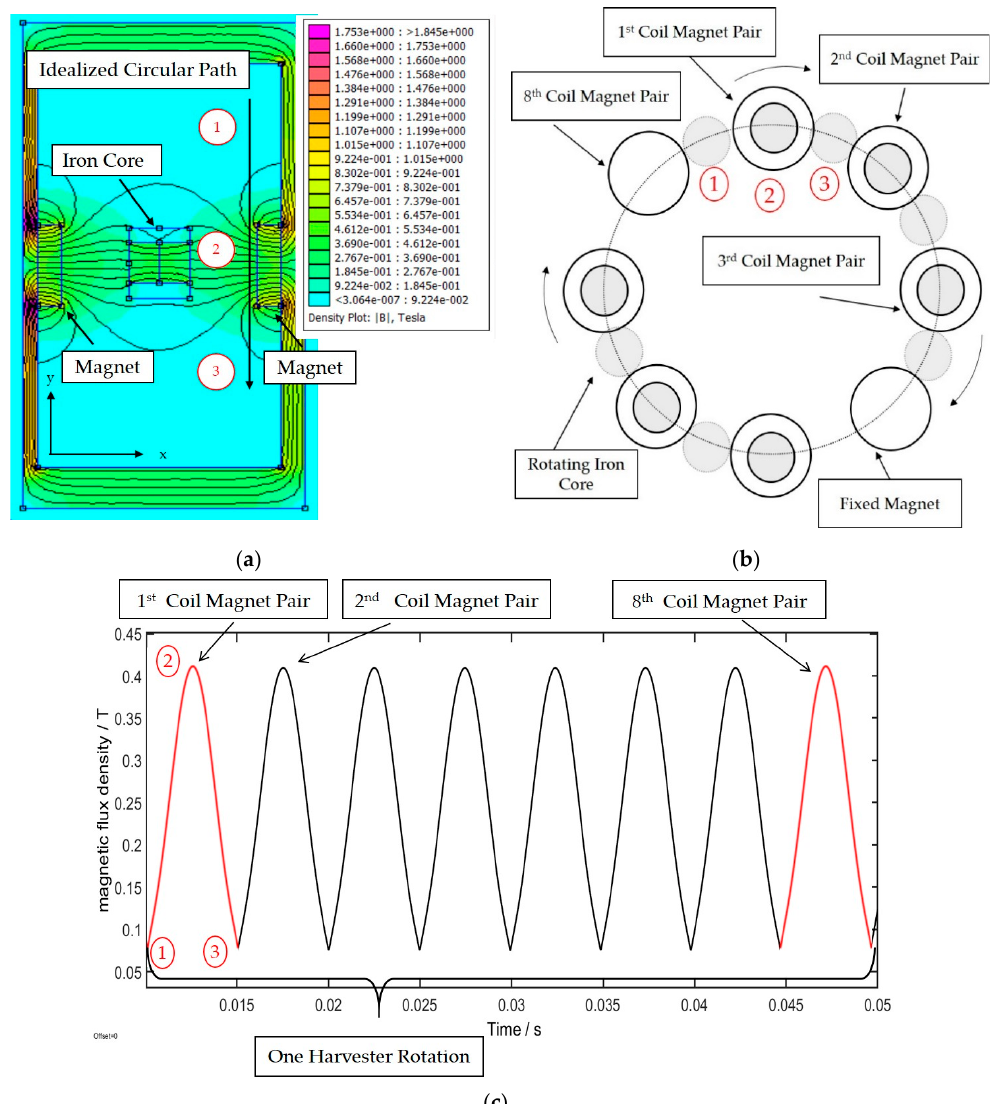
Figure 2. ( a ) Substitute simulation model of magnetic flux density B in tesla, top view; ( b ) axial view of harvester rotation, fixed magnets; ( c ) magnetic flux density of a harvester rotation. harvester rotation, fixed magnets; ( c ) magnetic flux density of a harvester The induction voltage represents the input variable for calculating the induction torque 𝑀 (cid:3036)(cid:3041)(cid:3031) . It represents the mechanical losses resulting from the use of electrical energy. From the aspect of power adjustment, an operating point results after the basic circuit where the maximum electrical power can be expected. The operating point is set by a resistance ratio between internal resistance 𝑅 (cid:3036) and load